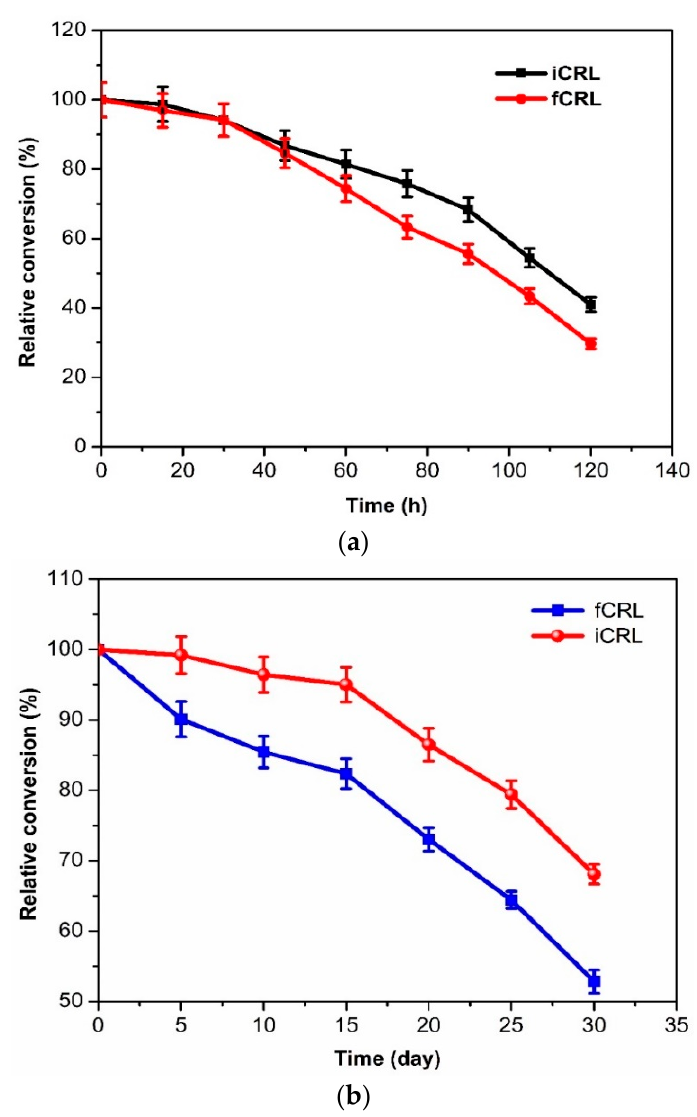
Figure 5. ( a ) Half-life of free CRL and CRL/SiO 2 /Fe 3 O 4 /GO biocatalysts at 50 °C, and ( b ) storage stability of free CRL and CRL/SiO 2 /Fe 3 O 4 /GO biocatalysts at room temperature in the esterification synthesis of EV (3 mg/mL, 40 °C acid/ethanol molar ratio 1:2, 200 rpm, 3 h).